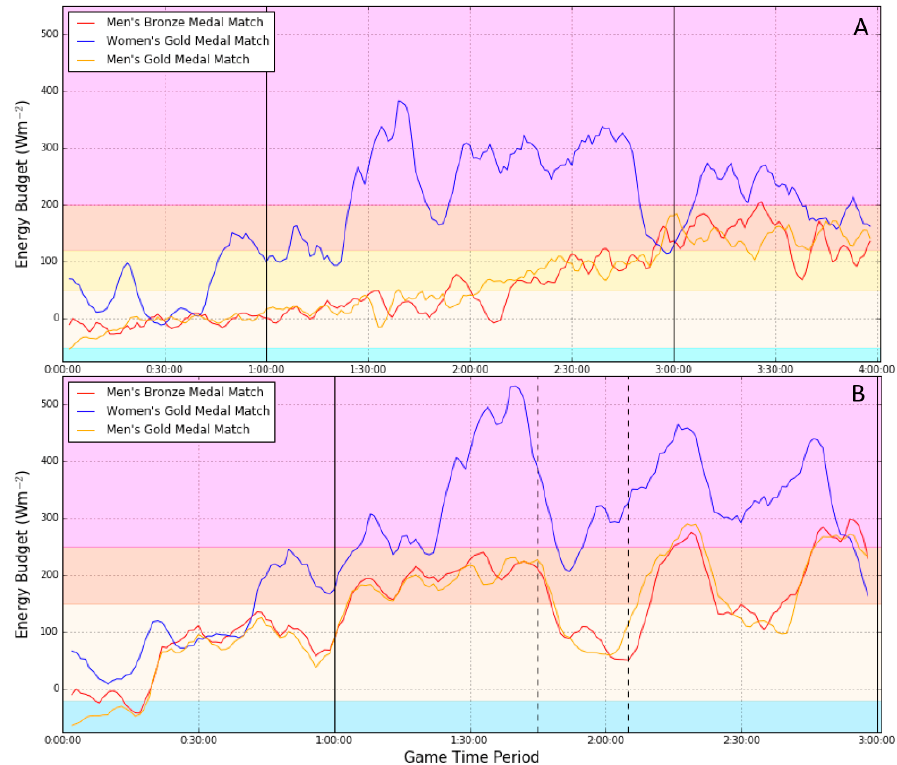
Figure 3. Temporal changes of the modeled energy budget of the spectators ( A ) and athletes (midfielders) ( B ). Lines represent three games: red line–Men’s Bronze Medal Match, 13:05–15:05, 25 July 2015; blue line–Women’s Gold Medal Match, 18:35–20:35, 25 July 2015; yellow line–Men’s Gold Medal Match, 13:05–15:05, 26 July 2015. Game start and end times are indicated by vertical solid lines. In ( B ), the half ‐ time break beginning and end times are also designated by vertical dashed lines. The background colors are indicative of the non ‐ active spectator ( A ) and athlete performing physical activity ( B ) subjective interpretation to the COMFA EB model output.